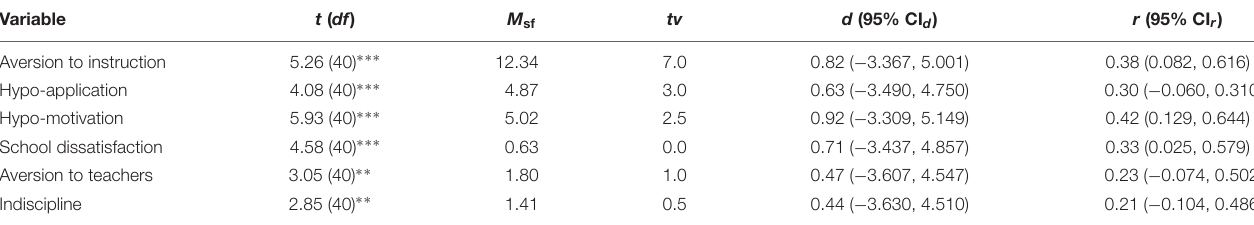
TABLE 4 | One sample t -test for the sub-dimensions of scholar maladjustment at level 3.